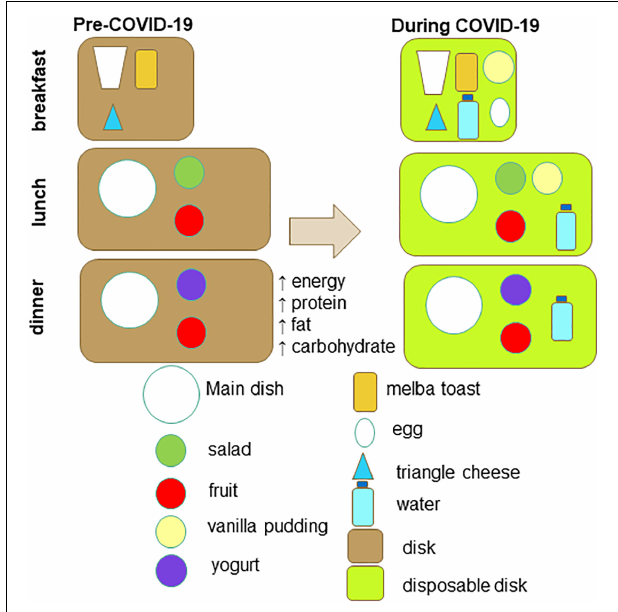
FIGURE 1 | Graphical presentation of the menu